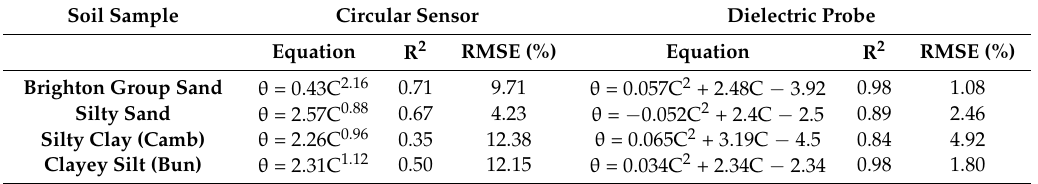
Table 2. Summary of the Circular Sensor and dielectric probe performance against each soil sample. Soil Sample